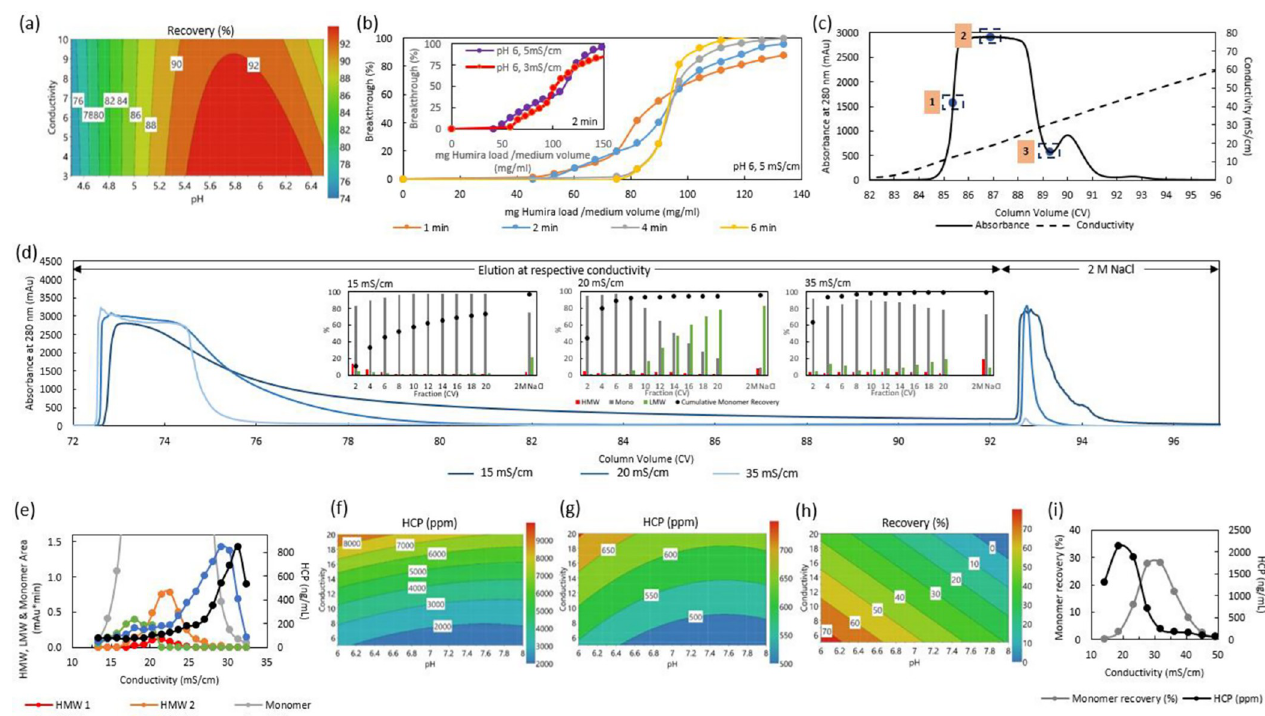
Fig 2. Optimisation of key process parameters for batch CEX capture and subsequent polishing steps. (a) 96-well plate screening of CEX load conditions. (b) Comparing the effect of different conductivities at pH 6, 2 min residence time (inset) and the effect of different residence times at pH 6, 5 mS/cm on the CEX loading breakthrough curves. (c) CEX AKTA gradient elution profile using 0–1 M NaCl 20 CV gradient elution at pH 6.0. (d) CEX AKTA step elution profile at 15 mS/cm, 20 mS/cm and 35 mS/cm, with the inset illustrating the relative percentage of HMW, LMW and monomeric species as well as the cumulative monomer recovery. (e) A detailed analysis of the profile of different subgroups of HMW, LMW, monomer species as well as HCP obtained using a 0–500 mM NaCl 20 CV gradient at pH 6.0. (f–h) 96-well plate screening of optimal conditions for polishing steps using AEX (f) and HIC resins (g) in FT mode, as well as optimal loading condition for multimodal chromatography resin (h). (i) The monomer and HCP elution profile obtained on the multimodal chromatography resin as a function of different conductivities obtained using 0 – 1 M NaCl 20 CV gradient elution at pH 6.0.